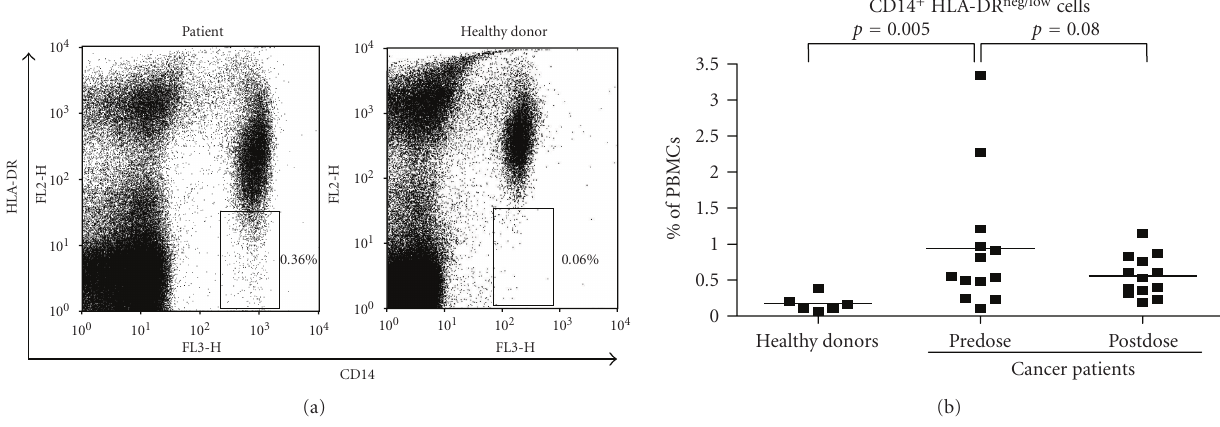
Figure 3: Results for myeloid suppressor cells (CD14 + HLA-DR neg/low ) in healthy donors and in cancer patients before and after VEGFR inhibition. Typical results of myeloid suppressor cells in a patient and one healthy donor are shown (a). Peripheral blood DC percentages are of total peripheral blood mononuclear cells. The individual values and the means for healthy donors and cancer patients before (predose) and after VEGFR TKI inhibition (postdose) are shown